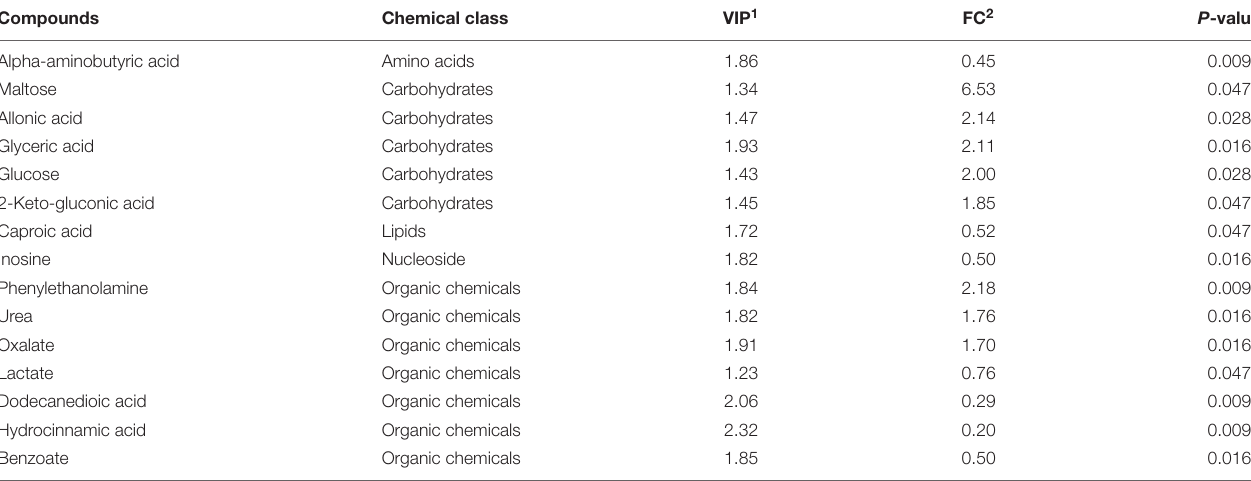
TABLE 1 | Candidate compounds in rumen epithelium that differed between hay (Hay) and high grain (HG) groups.